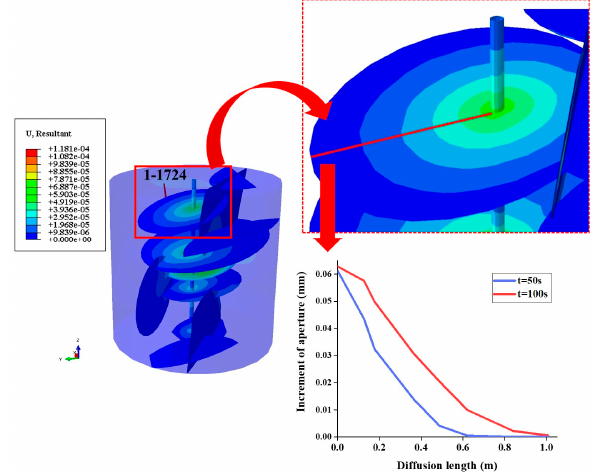
Figure 12. Fracture aperture variation along the grout diffusion length .